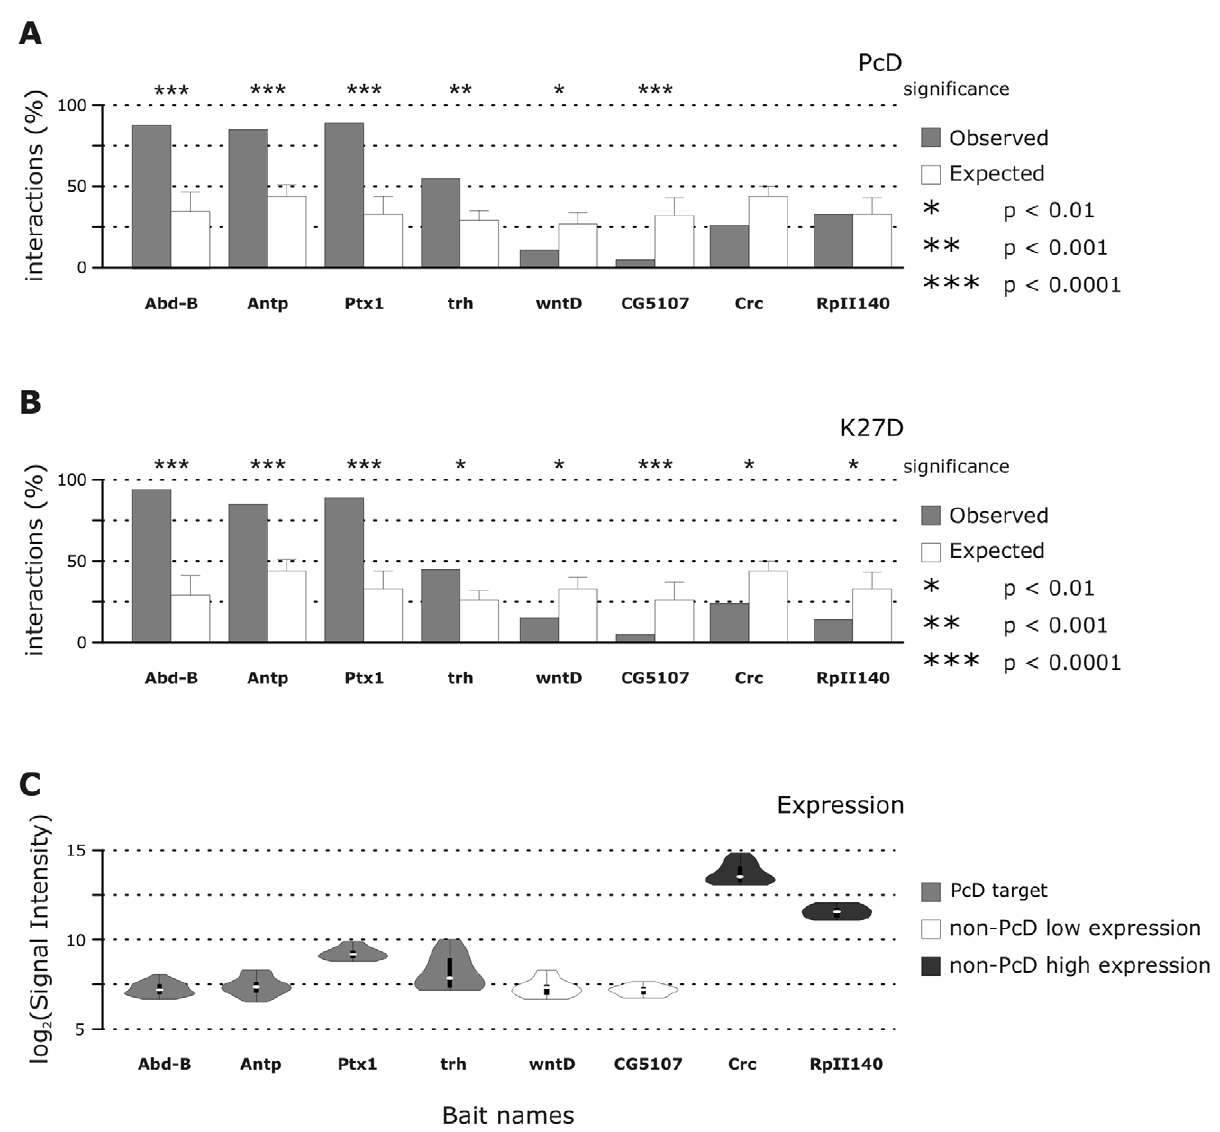
Figure 3. PcG targets interact specifically with PcDs and K27Ds. (A) Proportion of DIDs (y-axis) that overlap with PcDs is shown (observed - grey bars) and compared to an overlap based after random permutation (expected – white bars). Random sampling was repeated 1000-times and the bars show the average random overlap, while the error-bars show the standard deviation. Significance levels were determined using Pearson’s chi- square ( x 2 ) goodness of fit test and are indicated. Bait names are given (x-axis). (B) Proportion of DIDs that overlap with K27Ds. Plot details are descirbed in A. (C) mRNA expression levels of all baits as detected in 3 rd instar larval central brain cells are shown in violin plots. Violin plots are a combination of box plots and smoothed histograms. Median values are indicated by white dot, lower and upper quartiles by black rectangle, and sample minima/maxima by black line. Smoothed histograms of the four PcG-target baits are depicted in light grey, lowly expressed non-target genes in white and highly expressed genes in dark grey. Data represents four replicate microarray experiments. Genes were probed multiple times in each experiment, giving 48 ( Antp ), 32 ( Abd-B ), and 16 (all other genes) data points. Notably, Ptx1 is higher expressed than the three other PcG targets, because it is expressed in a subset of larval brain cells (Figure S6, Text